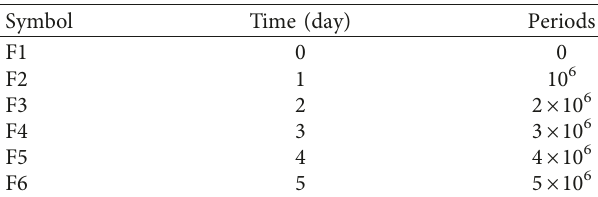
Table 2 and Figure 16 show the following: (i) Corresponding to 6 different fatigue states (from 0 to 6), the value of the frequency on the beam is almost unchanged (0.5 Hz) (according to Table 2).